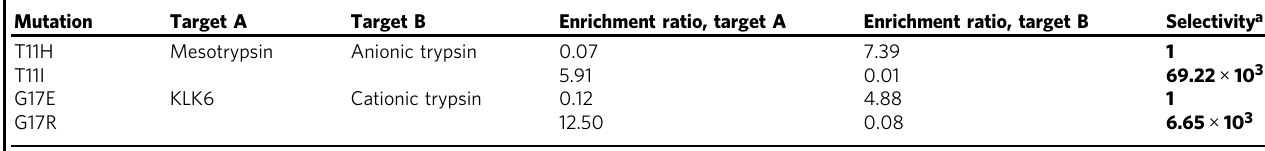
Table 1 Selectivity of APPI-3M variants with mutations at selectivity-switch residues toward human serine